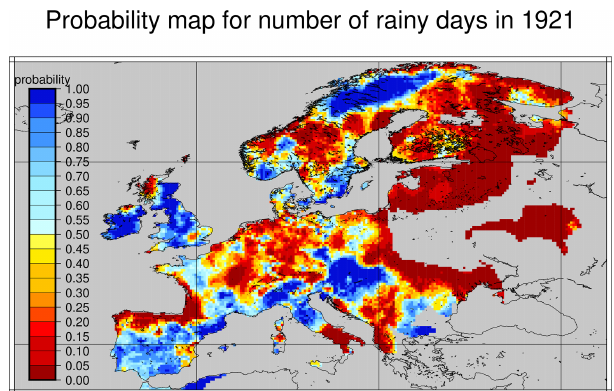
Figure 7. Probability-scaled map of the number of rainy days for 1921, using the 1981–2010 period as a base period to calculate the expected value. The map shows the probability to observe the same number of rainy days in the 1981–2020 climate as was observed in the 1921